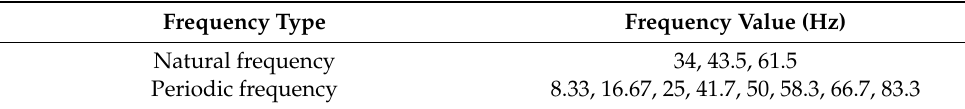
Table 3. Frequency identification results of the main beam.